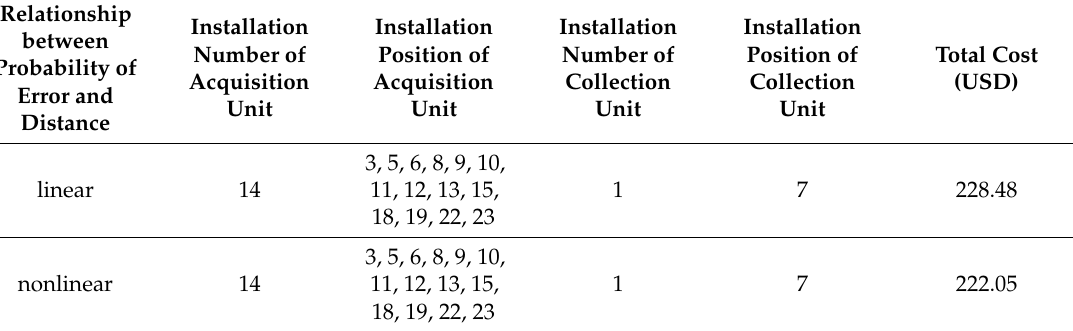
Table 6. Optional placement of fault indicators under di ff erent relationships between probability of error and